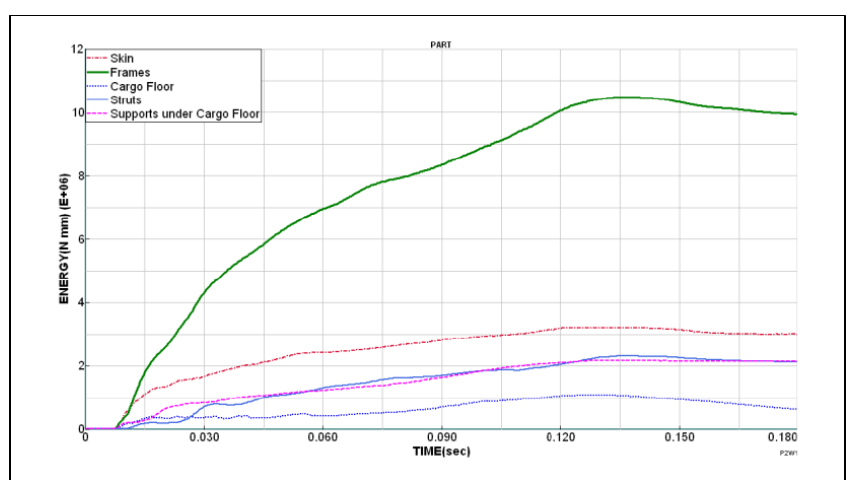
Figure 4: Energy vs time curve of each component (P. Xue et al., 2014) 9